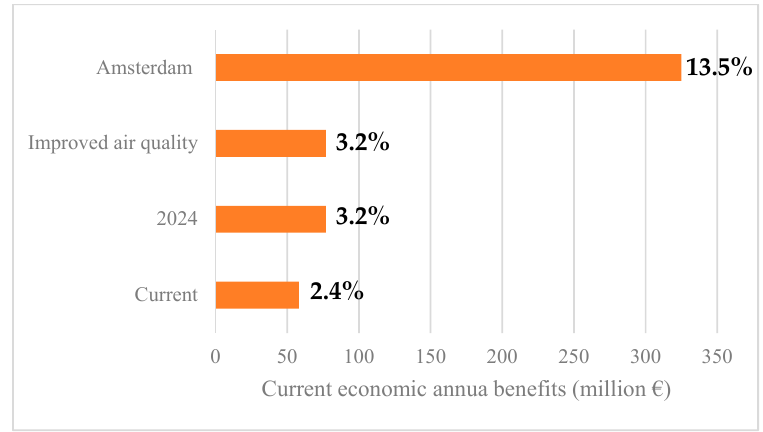
Figure 8. Annual economic benefits and percentage of the health cost paid each year by the city of Milan.